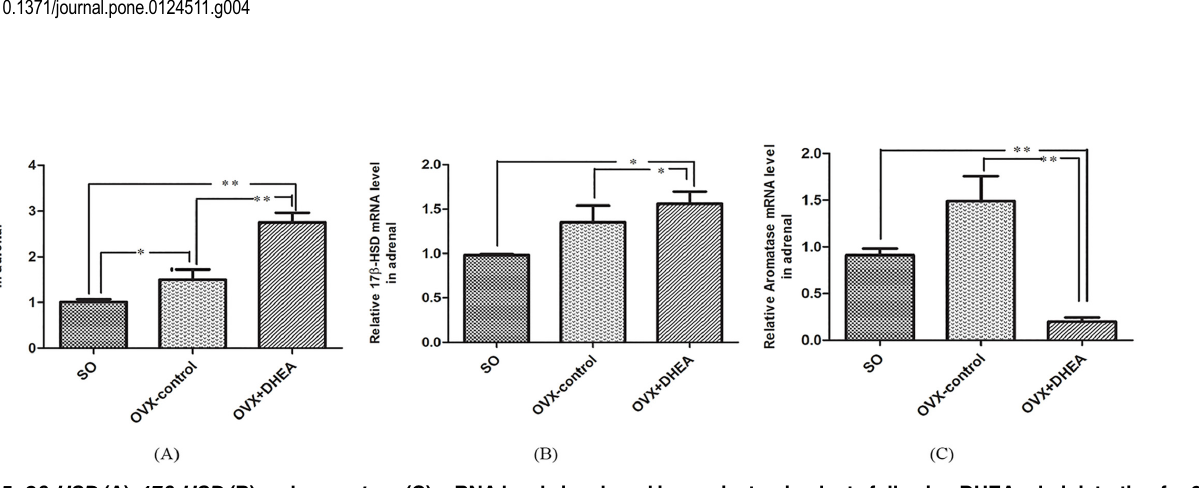
PLOS ONE | DOI:10.1371/journal.pone.0124511 May 11,